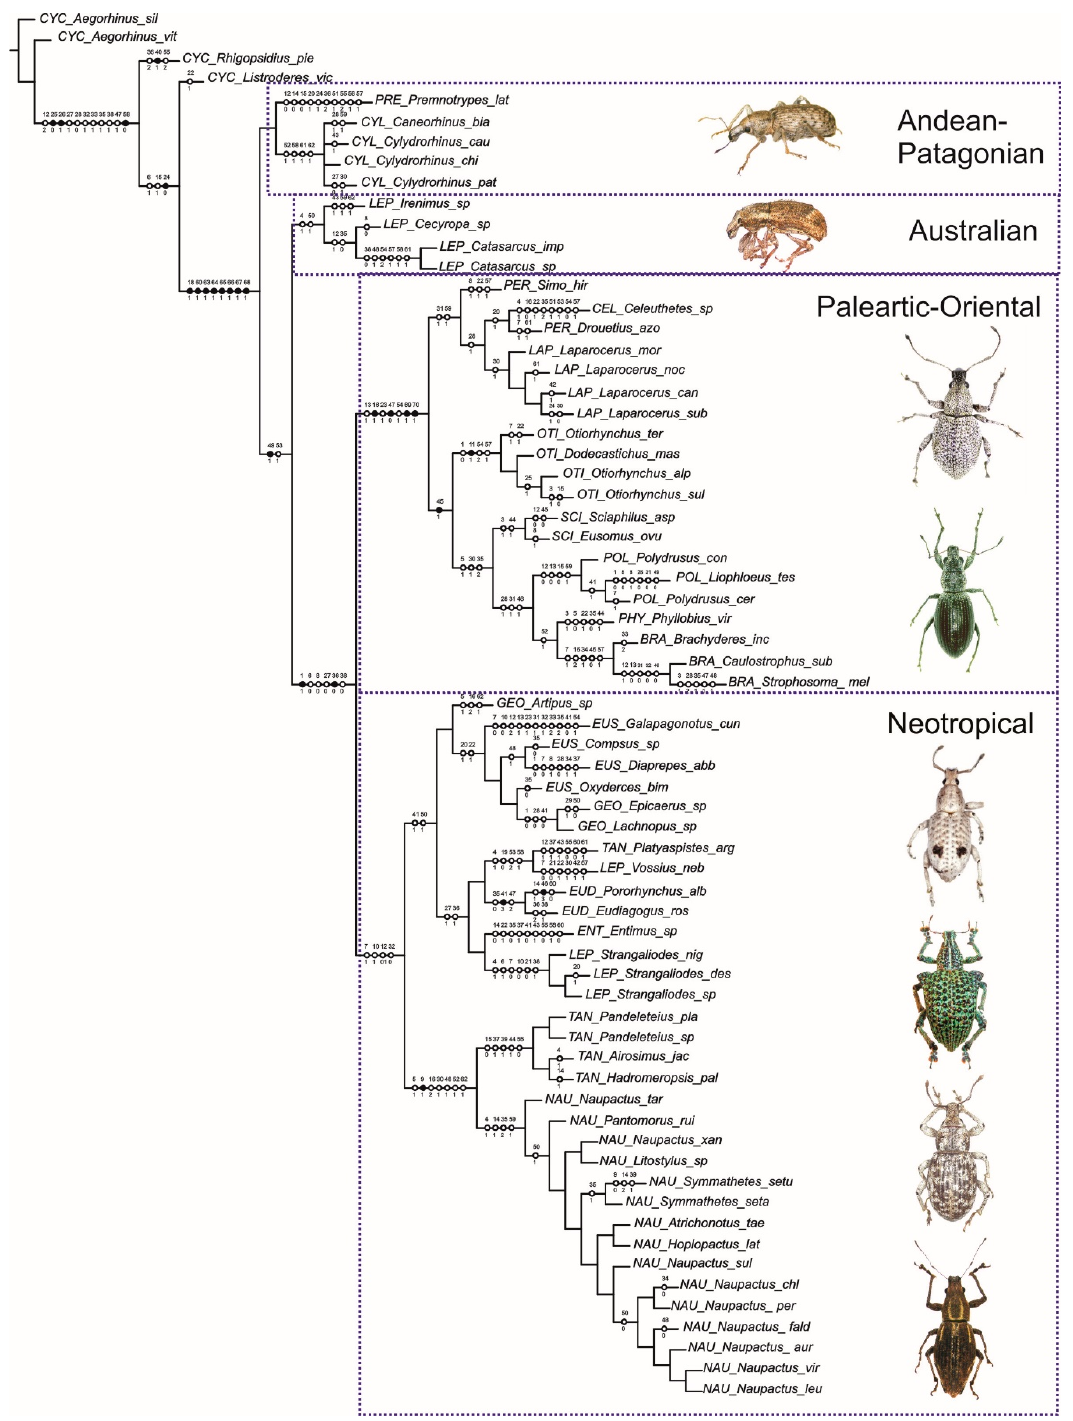
Figure 7. Most parsimonious tree of Entiminae, selected from the four MPTs obtained after combined parsimony analysis. Morphological unambiguous character changes are indicated at branches, with numbers above and below corresponding to character and state, respectively; unique changes are in black and homoplastic changes in white. The most important clades are illustrated and highlighted with boxes and their main biogeographic areas are indicated.